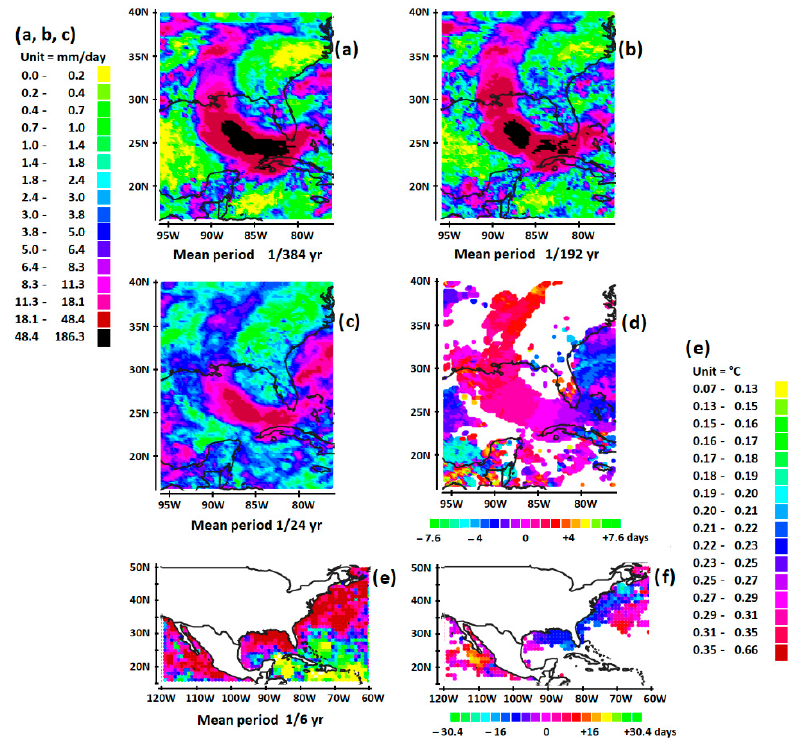
Figure 14. Extreme rainfall in Louisiana, USA. Same conventions as in Figure 7. Time lags in ( d , f ) are expressed in relation to 29 August 2005. The time reference is the rainfall depth at 29° N, 89° W. Co-Evolution of SST and Rainfall Anomalies in Characteristic Period